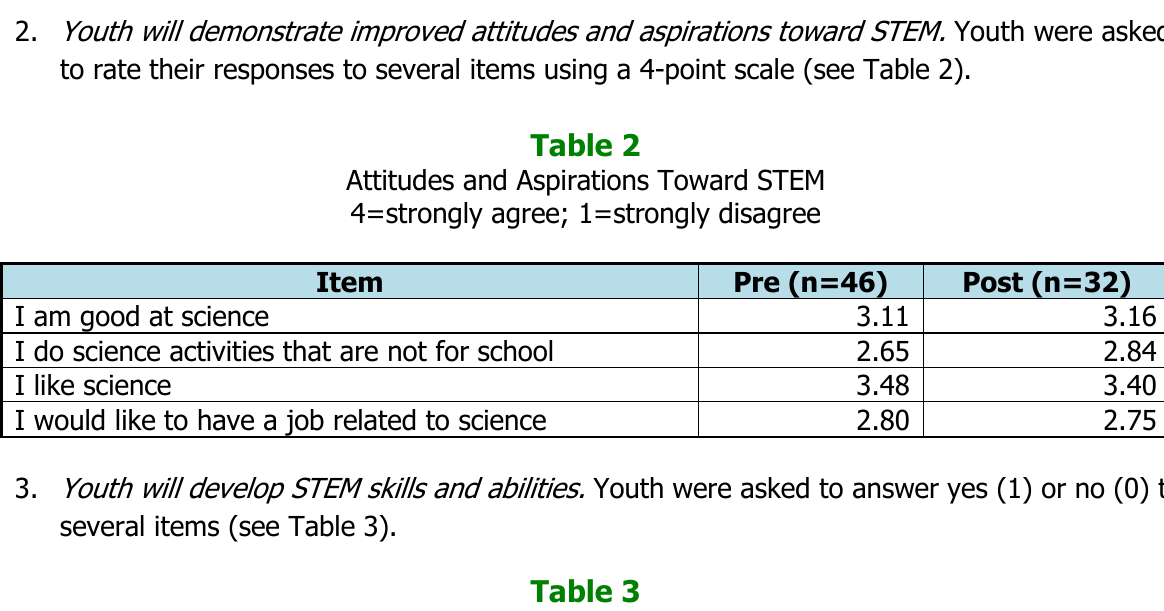
Develop STEM Skills and